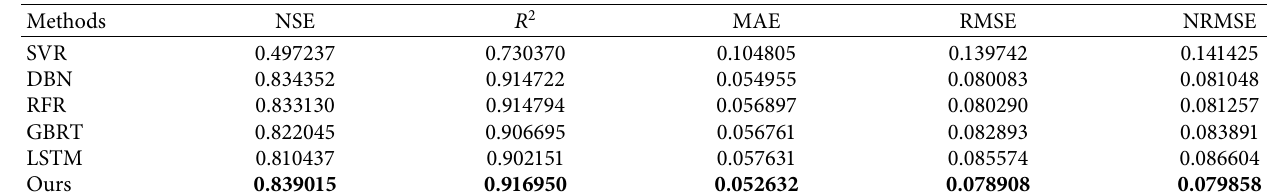
Table 1: Evaluation results for lead time of 3h.